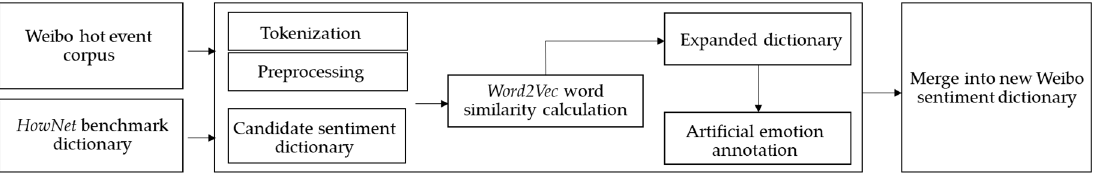
Figure 4. Flow chart of the incremental expansion of the reference dictionary.